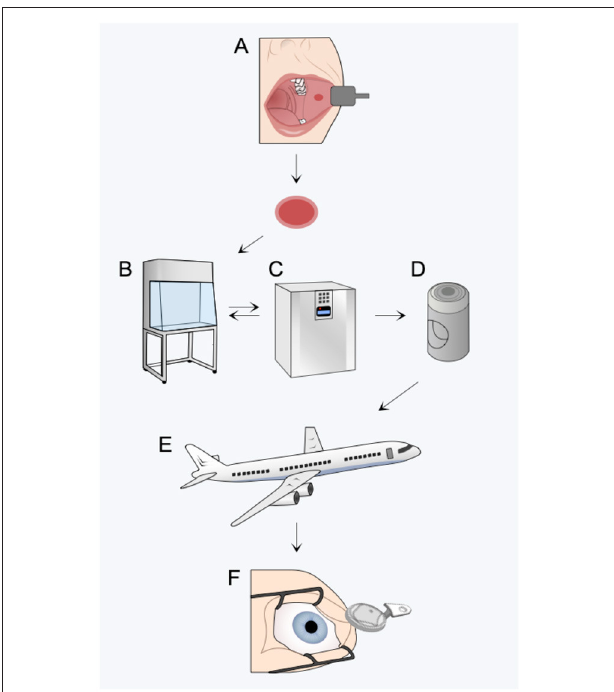
FIGURE 1 | Optimizing storage technologies can improve access to novel regenerative medicine therapies by ensuring graft quality throughout harvest (A) , manipulation (B) , expansion (C) , packaging (D) , transport (E) , and transplantation (F)